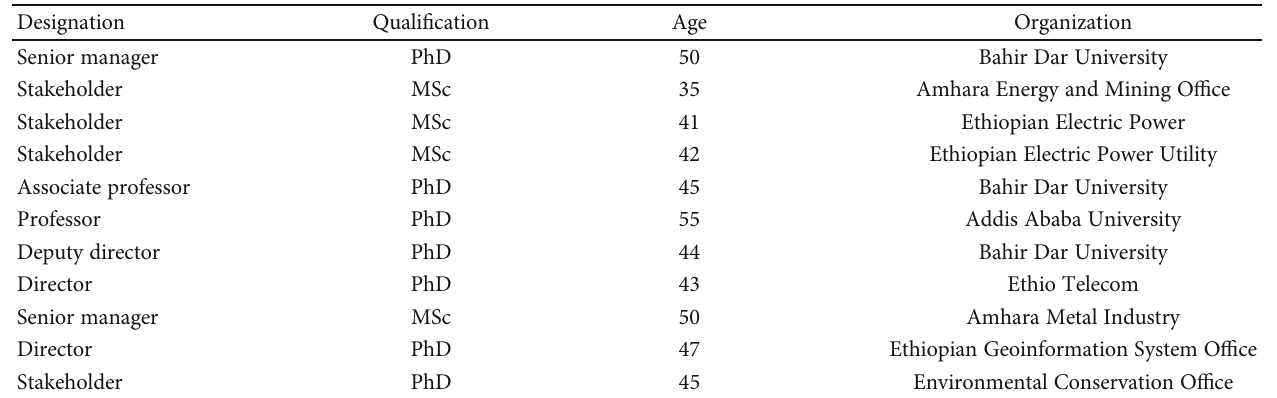
Table 3: Information on experts